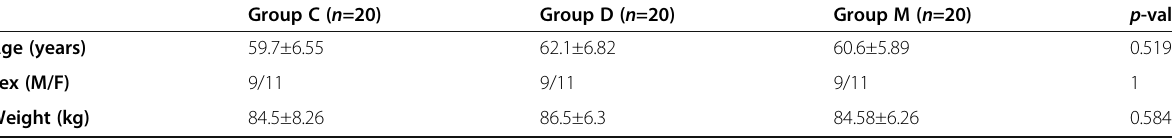
Table 1 Comparison between the three study groups regarding demographic